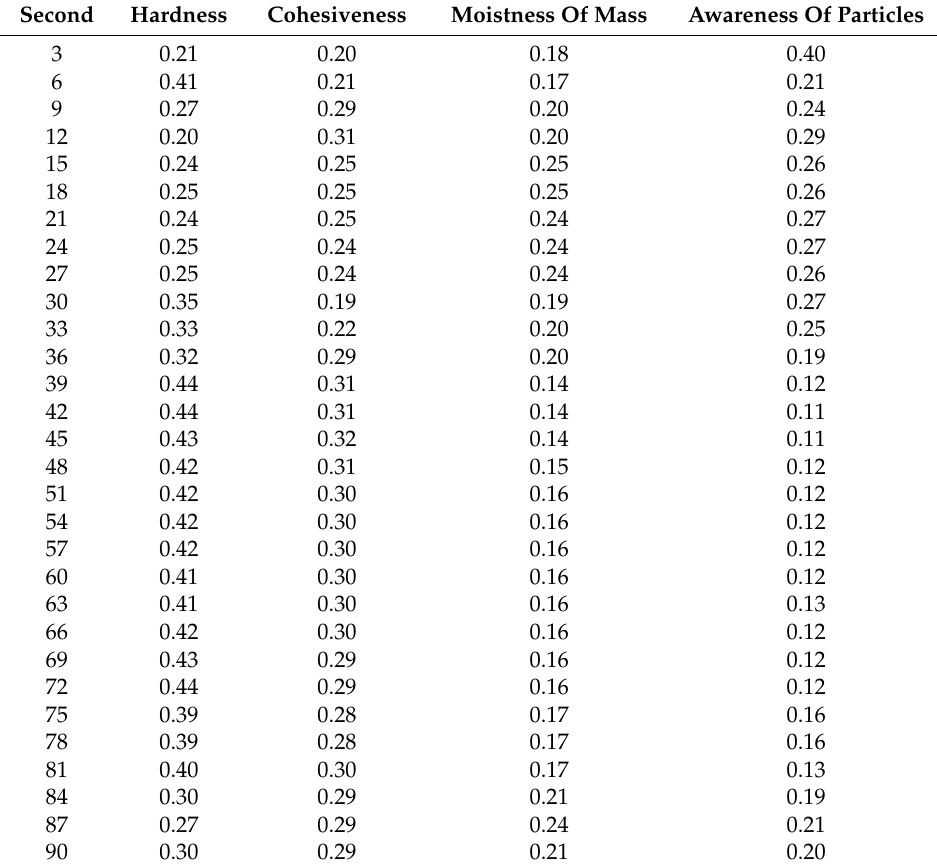
Table 1. Shapley values for each panel descriptive attribute to Overall Liking of Texture varying with time